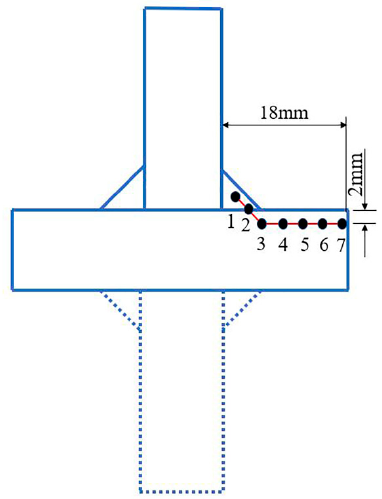
Figure 12. Vickers hardness measurement locations.